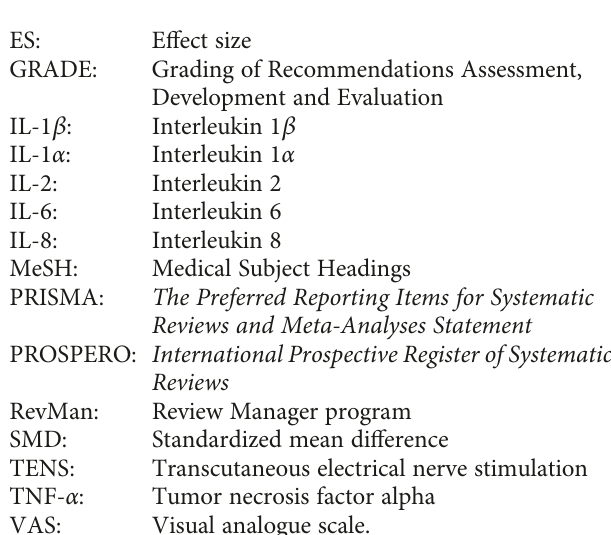
Supplementary Material 1: checklist PRISMA.